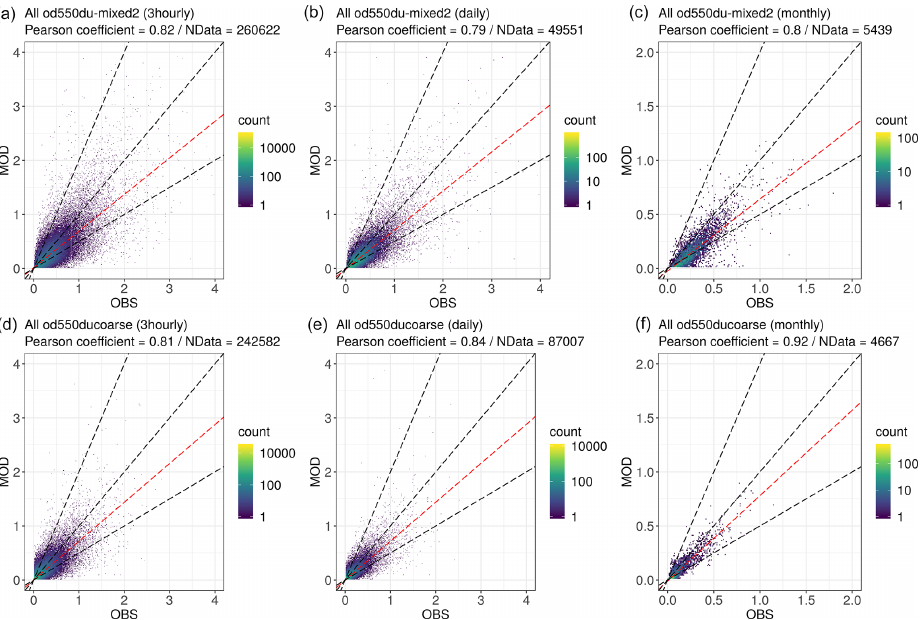
Figure 10. Density scatter plots of the reanalysis (MOD) DOD and DOD coarse versus AERONET (OBS) dust-filtered AOD, DOD- mixed2 (a–c) and DOD coarse (d–f) , during the whole reanalysis period (2007–2016). The results are calculated for the NAMEE domain and for different time basis: 3-hourly (a,d) , daily (b,e) and monthly (c,f) . The dust filters applied to the AERONET observations are described in Table 6. The bin size is 0.01.